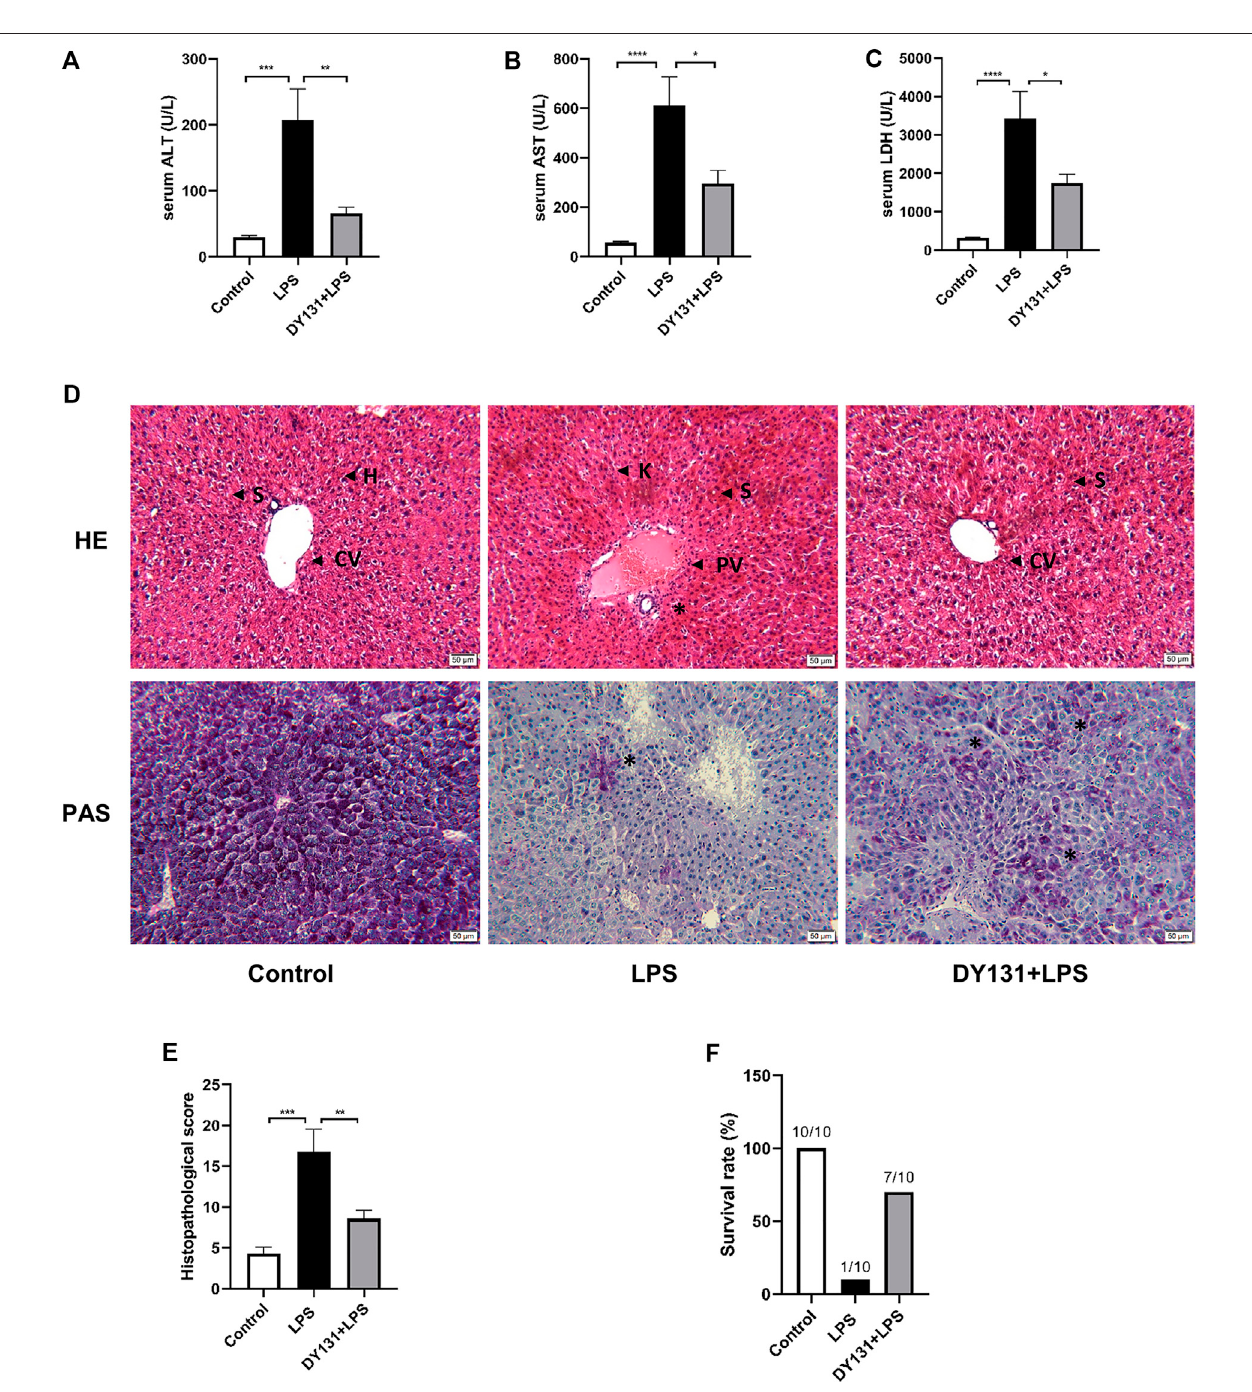
FIGURE 2 | Pretreatment with DY131 attenuated LPS-induced liver injury. Mice were pretreated with DY131 prior to LPS challenge as described in materials and methods. (A – C) Serum levels of ALT, AST, and LDH (n (cid:1) 10 in each group). (D) Representative images of H&E and PAS staining of liver sections (magni fi cation × 200, scale bar: 50 μ m). CV, central vein; H, hepatocytes; S, sinusoids; PV, portal vein; K, Kupffer cells; asterisks* indicated in fl ammatory in fi ltrations in portal areas (H&E) and PAS-positive materials in hepatocytes (purple-stained). (E) Analysis of liver histopathological score in different groups based on H&E staining images (n (cid:1) 4 – 7 in each group). (F) Survival rate at the 48 h after LPS challenge. Data were presented as means ± SEM. * p < 0.05, ** p < 0.01, *** p < 0.001, and **** p < 0.0001 vs. the indicated group.